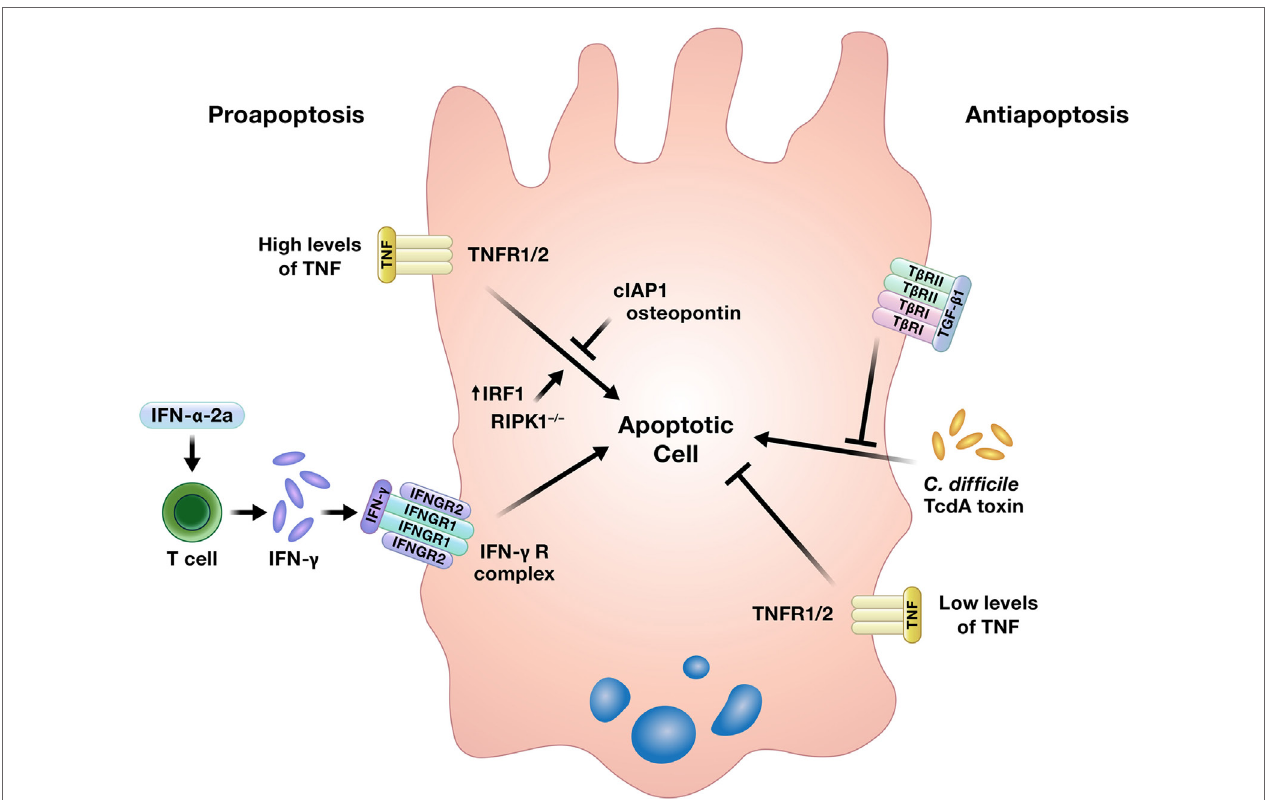
FiGURe 3 | Cytokines can induce or prevent apoptosis in intestinal epithelial cells. TNF has been shown to either promote or inhibit intestinal epithelial cell apoptosis under different conditions. Abbreviations: IAP, inhibitor of apoptosis protein; IRF1, interferon regulatory factor 1; RIPK1, receptor interacting protein kinase 1; TNF, tumor necrosis